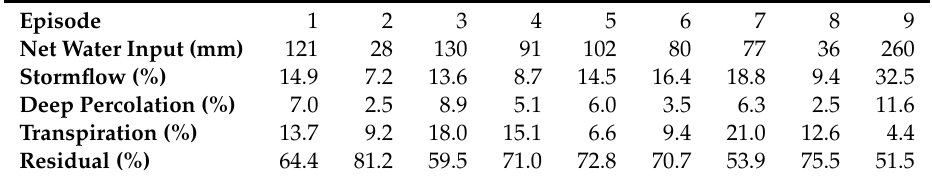
Table 6. Mass fractions of tracer relative to applied mass at the end of rainfall–runo ff episodes. Net water input is rainfall minus actual